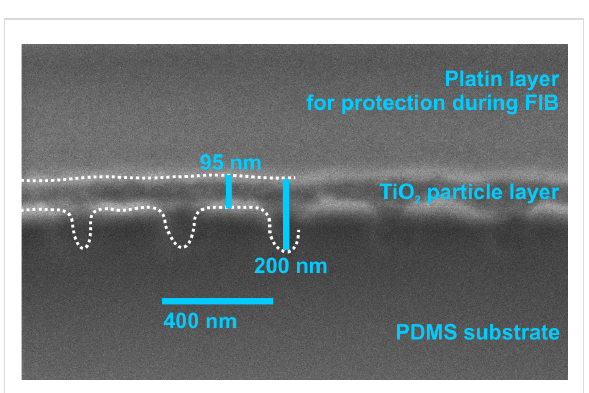
Figure 7: Cross-section of a 400 nm grating on a PDMS membrane with a particle layer created by a 6 wt % solution viewed with a scan- ning electron microscope (SEM). The cross-section was created with a focused ion beam (FIB). To protect the cutting edge, a layer of plati- num was added on top of the sample. The structure itself is empha- sized because of charging effects at the PDMS material border. For optical enhancement dotted guiding lines were drawn into the cross- section. The TiO 2 layer is non conductive, therefore features as small as the average particle size ( ≈ 21 nm) cannot be seen in the scan. The high index layer can be identified as the dark layer between the struc- tured PDMS substrate and the conductive platinum protection layer on top. It evens out the nanostructure of the substrate and has a thick- ness of 95 to 200